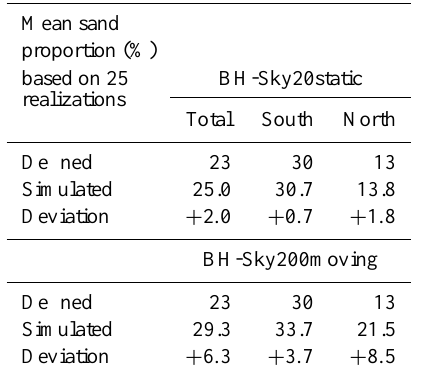
Table 3. Simulated and defined sand proportions for the to- tal domain and two subdomains based on two simulations with different soft conditioning data sets (BH-Sky20static and BH- Sky200moving), based on 25 realizations.